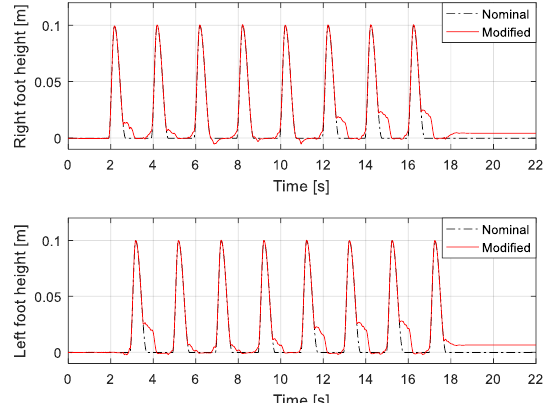
Figure 20. Feet height trajectory under varying local and global slopes.